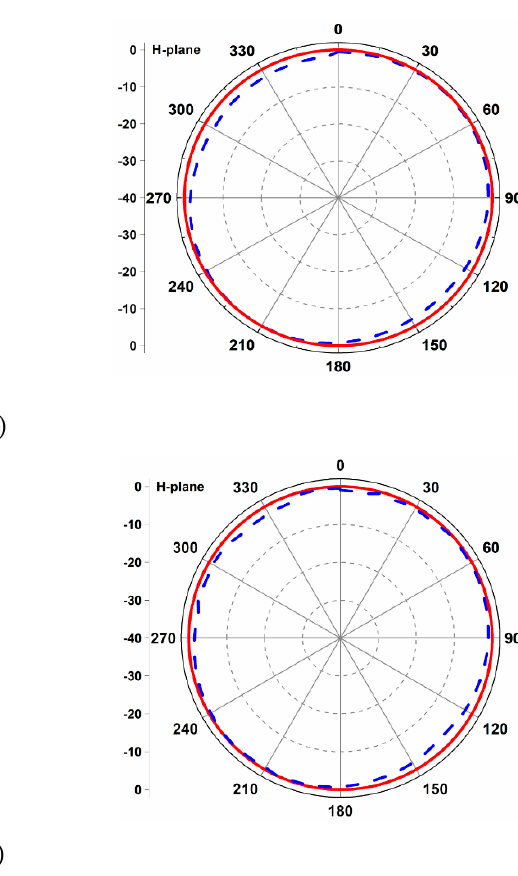
Figure 18. Simulated (solid line) and measured (dashed line) radiation patterns of modified UWB filtering antenna array: ( a ) At 3 GHz, ( b ) At 5 GHz, and ( c ) At 9 GHz.